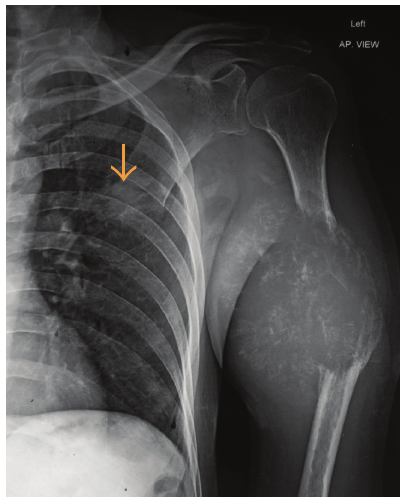
Figure 1: CXR-PA view showing osteolytic lesion in left mid- humerus and a spiculated nodule in left